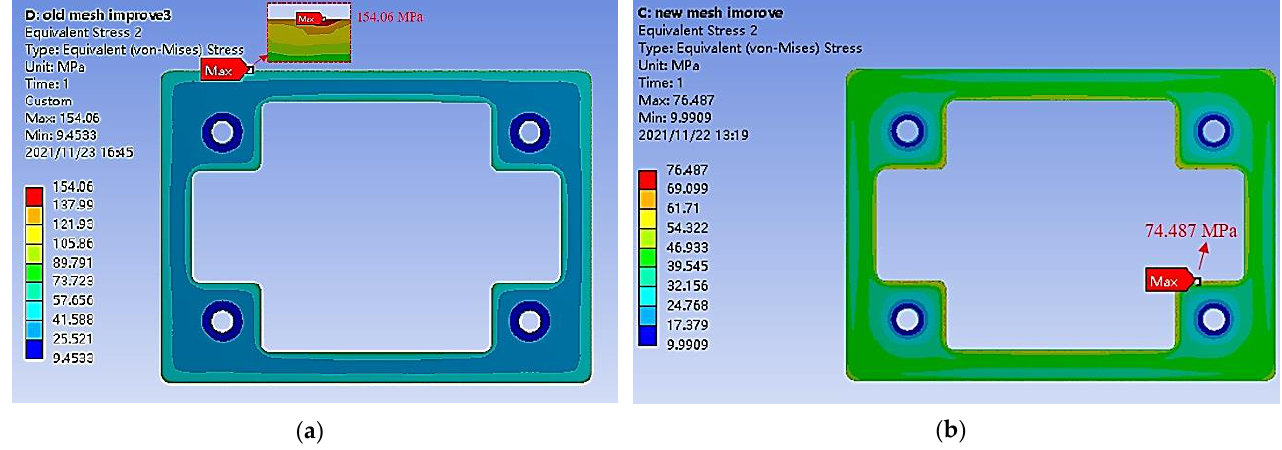
Figure 10. The maximal equivalent stress value distribution comparison of ( a ) the typical fan in the SAW filter structure without a polymer layer mold and with ( b ) the top-side molded SAW filter WLP.